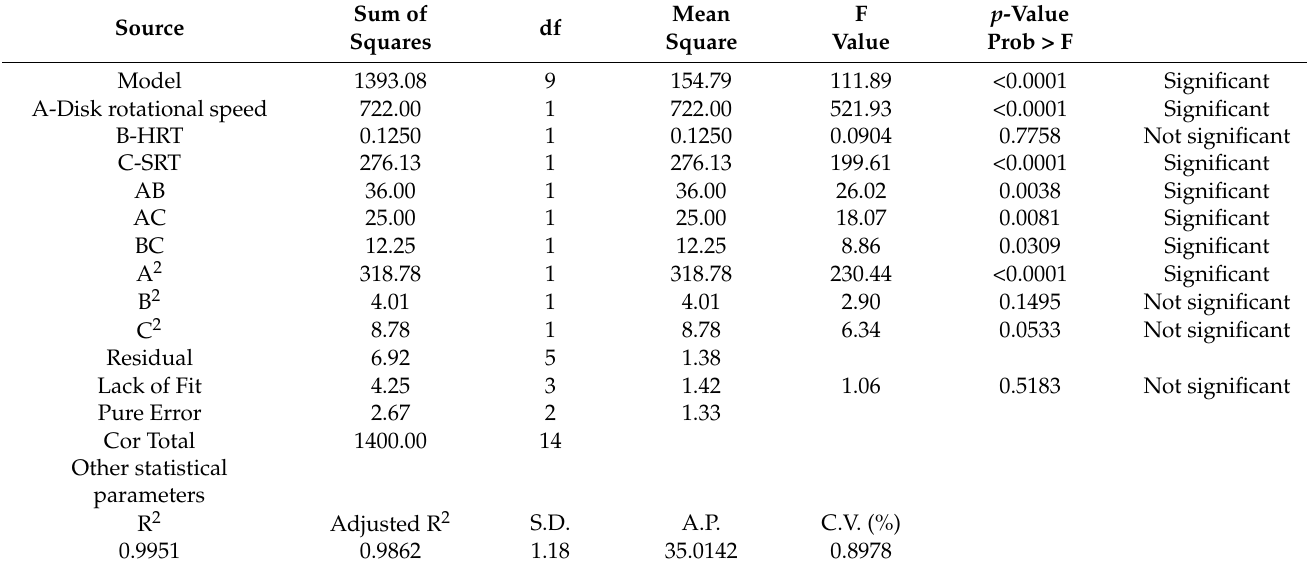
Table 6. ANOVA results of the coefficient of the quadratic model for steady-state membrane permeability. Sum Source